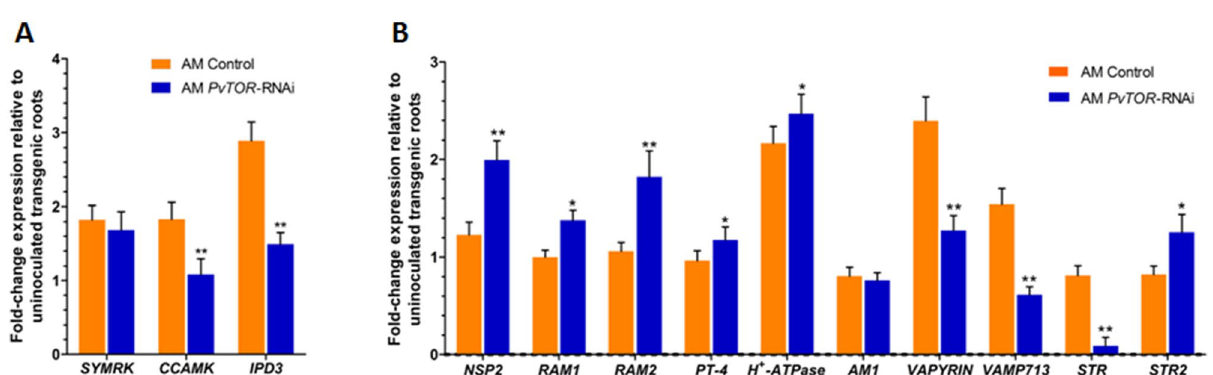
Figure 8. Expression of P. vulgaris AM regulatory genes in R. irregularis -inoculated transgenic roots. ( A ) RT-qPCR analysis of the transcript levels of CSSP genes and AM fungi induced TFs genes in control and PvTOR -RNAi transgenic roots at 1 wpi. ( B ) RT-qPCR analysis of the transcript levels of mycorrhizal-induced genes in control and PvTOR -RNAi transgenic roots at 1 wpi. ( A & B ) Quantitative RT-PCR was performed on cDNA of root RNA samples. The statistical significance of differences between mycorrhized roots of control and PvTOR -RNAi plants was determined using an unpaired two-tailed Student’s t -test (*P < 0.05; **P < 0.01). Error bars refer to the SE of the mean of three biological replicates (n > 9). CSSP, common symbiotic signaling pathway; AM, arbuscular mycorrhiza; TFs, transcription factors; wpi, week post